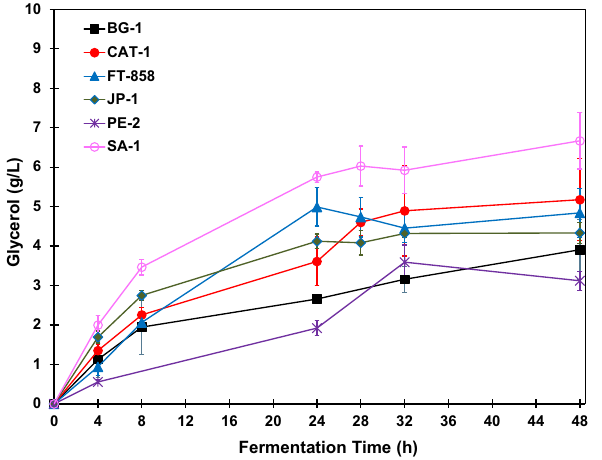
Figure 5. Glycerol concentration profiles during BRS PAMPA rice fermentations with S. cerevisiae strains. The error bar represents the standard deviation from the essays carried out in triplicate.